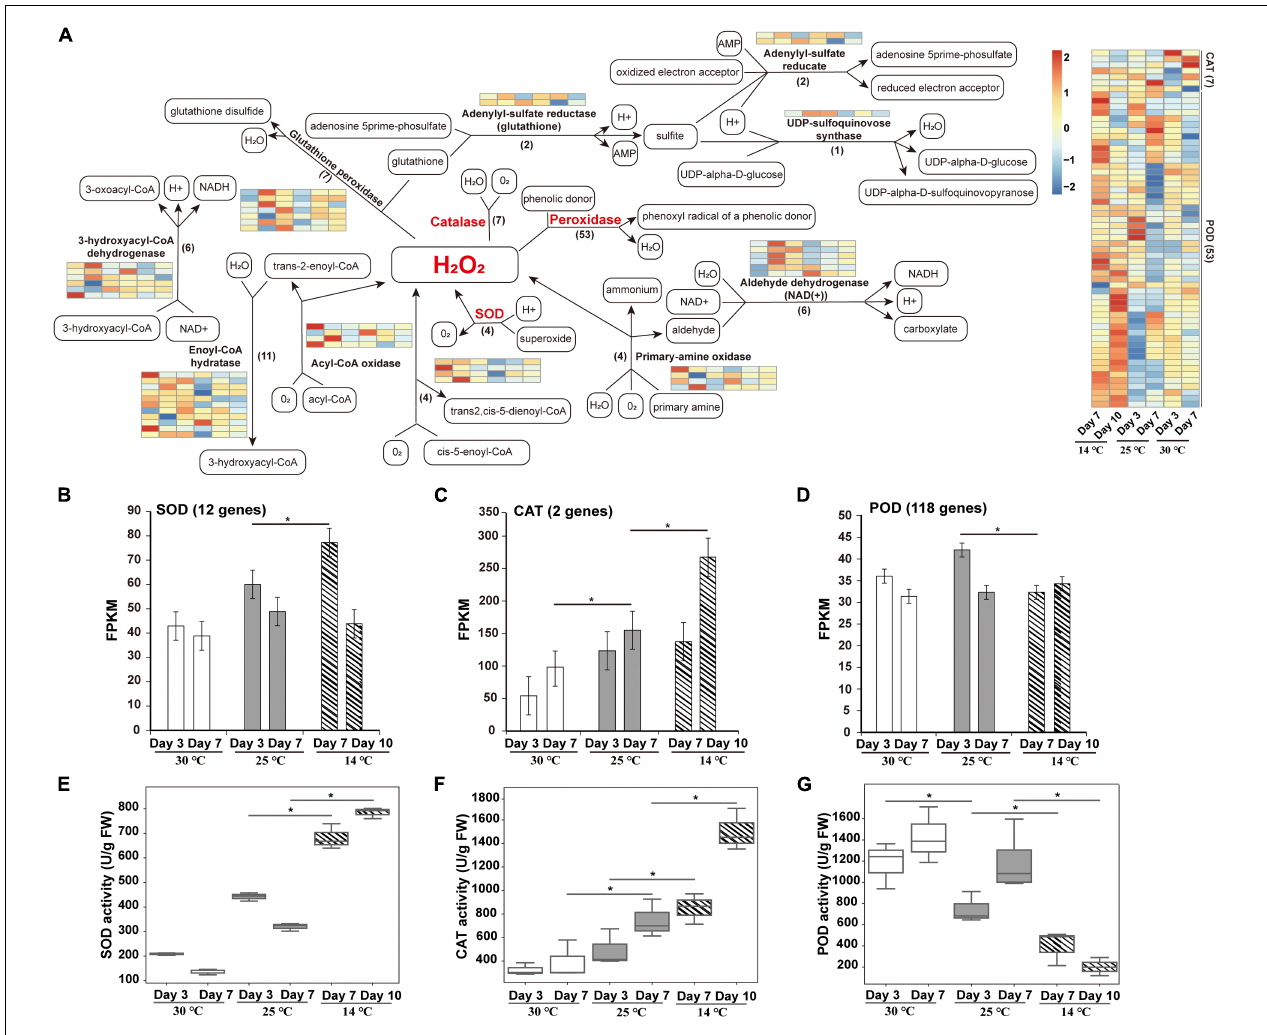
FIGURE 5 | Redox pathway enrichment analysis of DEPs identified during the germination of an M. micrantha seed at 14, 25, and 30 ◦ C. (A) Redox pathway connected by a black straight arrow line/a black dashed arrow line. Relative levels of DEPs expression are shown by a color gradient from low (blue) to high (red). (B–D) Fragments per kilobase of transcripts per million mapped fragments (FPKM) of genes involved in encoding SOD (B) , CAT (C) , and POD (D) . (E–G) Change in the relative specific activities of SOD (E) , CAT (F) , and POD (G) in M. micrantha germs exposed to cold stress. One-way ANOVA, p ≤ 0.05